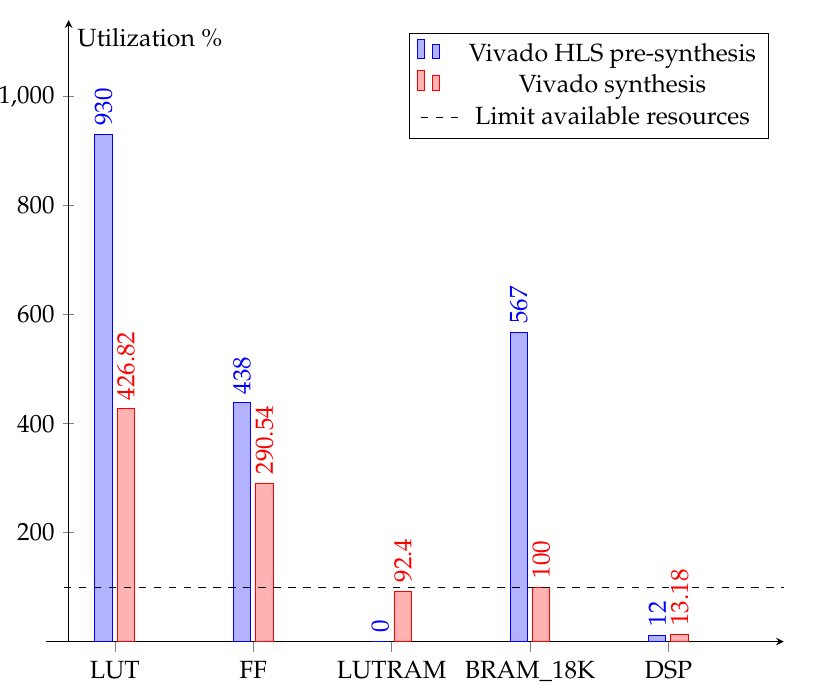
Figure 7. Resource estimation comparison between pre-synthesis and synthesis for the baseline CNN1D model on the Zynq